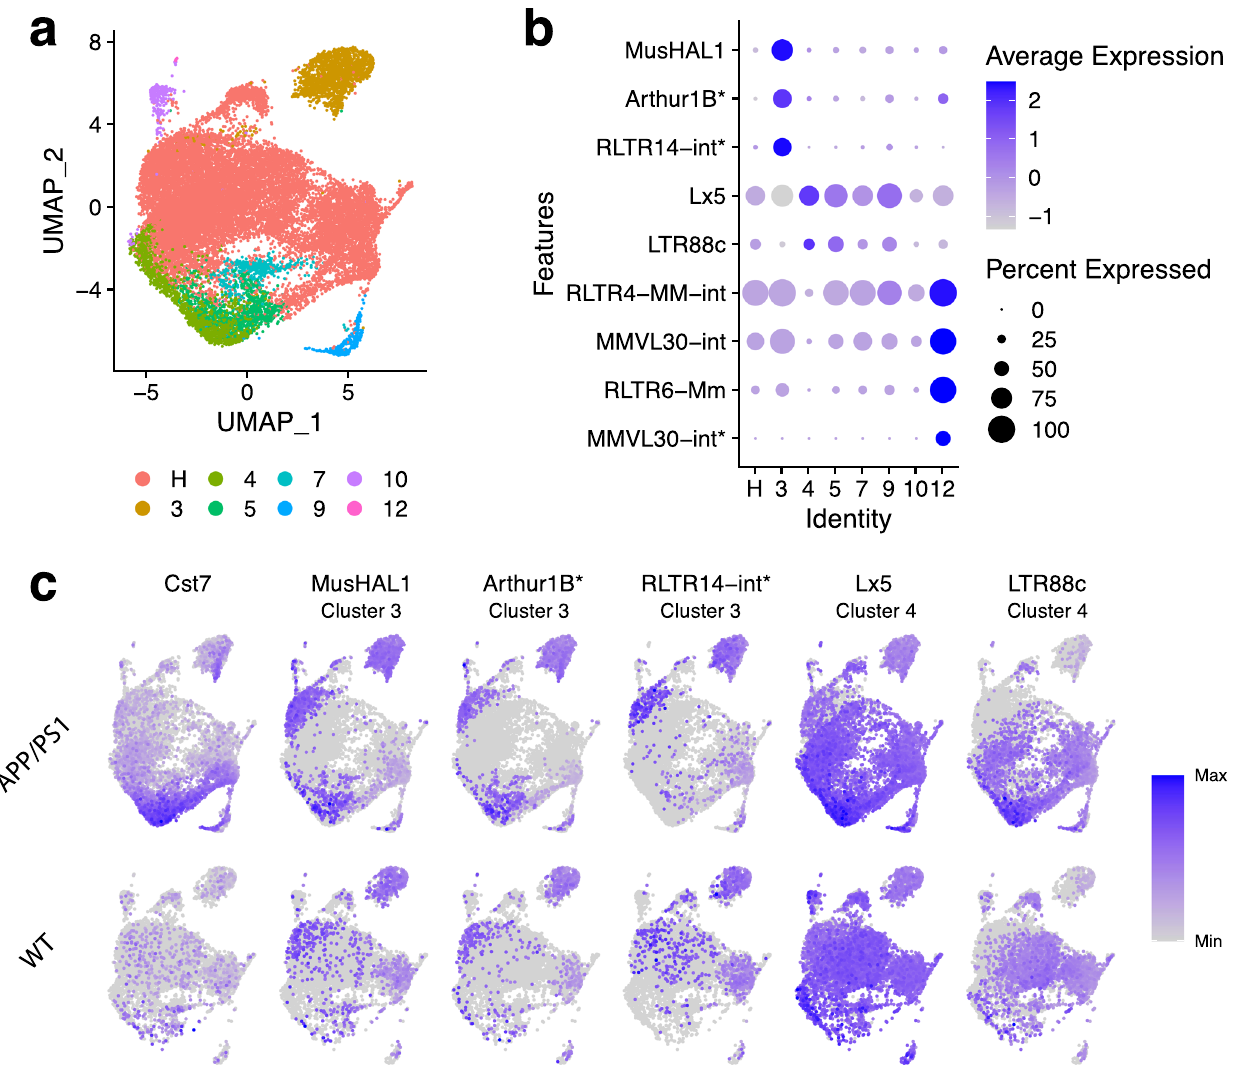
Fig. 6 TE expression detected with SoloTE in the APP/PS1 Alzheimer ’ s disease mouse model. a UMAP plot indicating the different cell types ( “ H ” : homeostatic cells). b Dot plot depicting marker TEs per cell types (indicated on the x axis), having a disease-speci fi c effect. c UMAP plots of Cst7 (known gene with increased expression in the disease) and selected TEs. Upper row corresponds to the expression in the AD APP/PS1 samples, whereas the lower row corresponds to the expression in the wild-type (WT) samples. Label below the TE identi fi er indicates the cluster at which the TE has increased expression. “ * ” denotes locus-speci fi